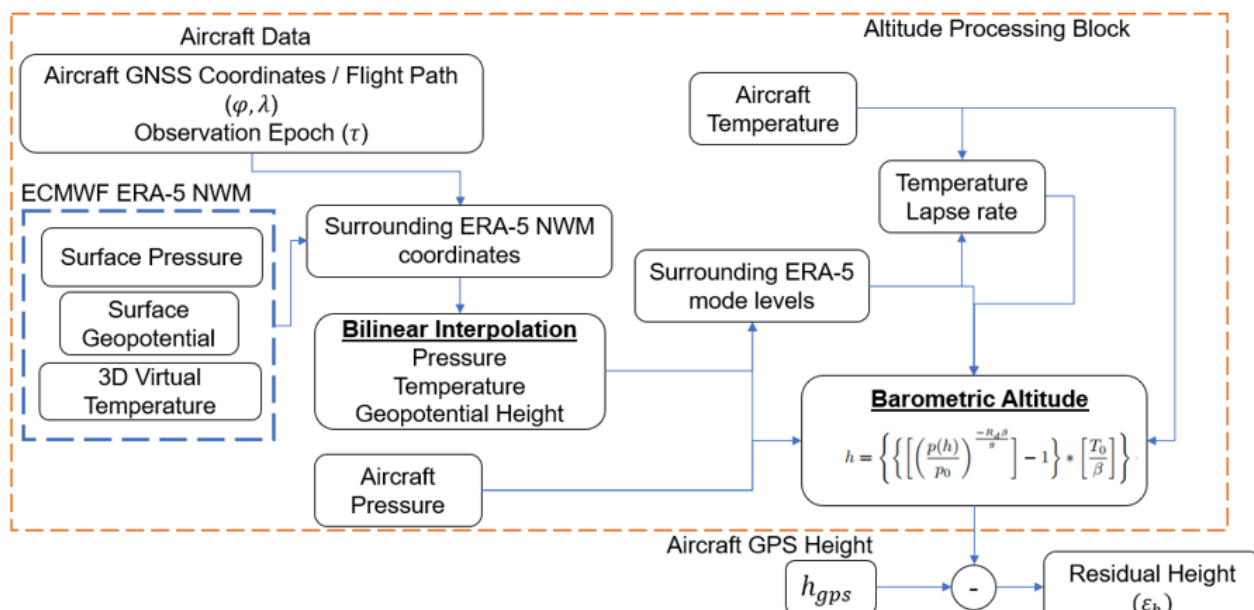
Figure 5. Computational setup for estimating barometric